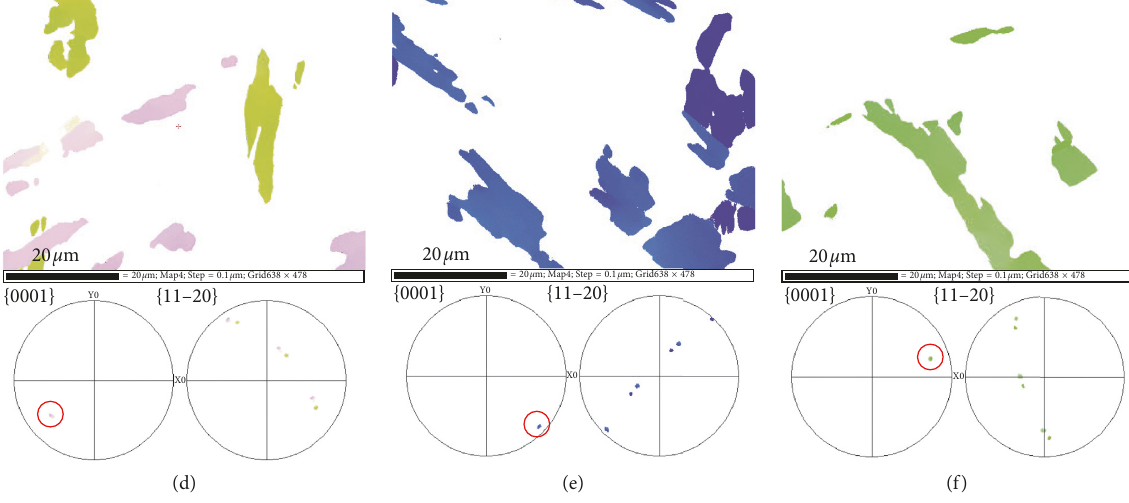
Figure 3: EBSD analysis of the 12 α variants with different orientations in Figure